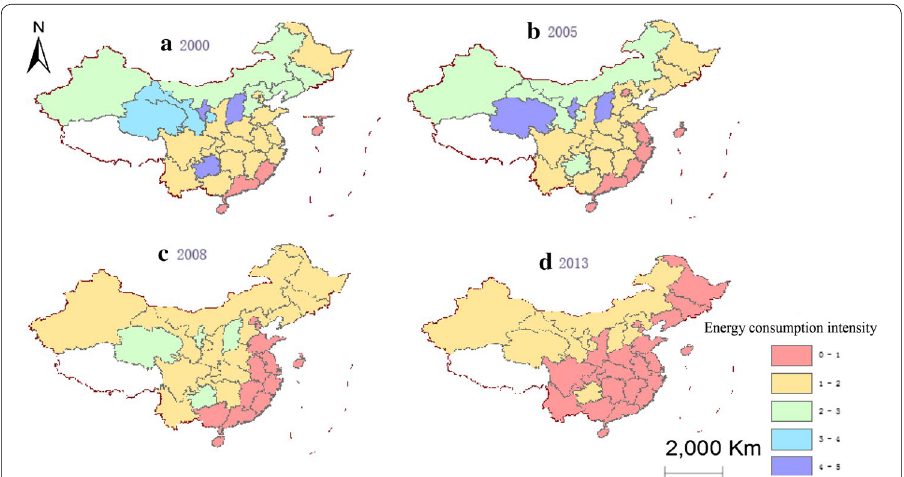
Fig. 3 The spatial distribution for the intensity of the energy consumption in China in a 2000, b 2005, c 2008, d